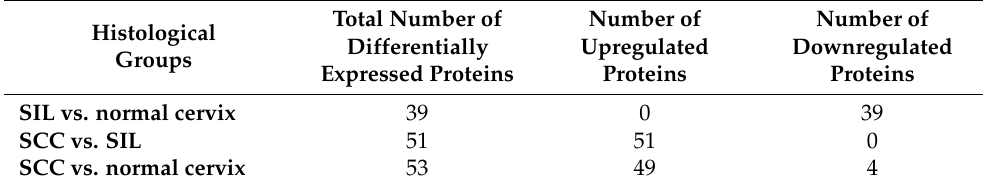
Table 1. Number of differentially expressed proteins in the histological. Number of Number of Total Number of Histological Downregulated Upregulated Differentially Groups Proteins Proteins Expressed Proteins SIL vs. normal cervix 39 0 39 SCC vs. SIL 51 0 SCC vs. normal